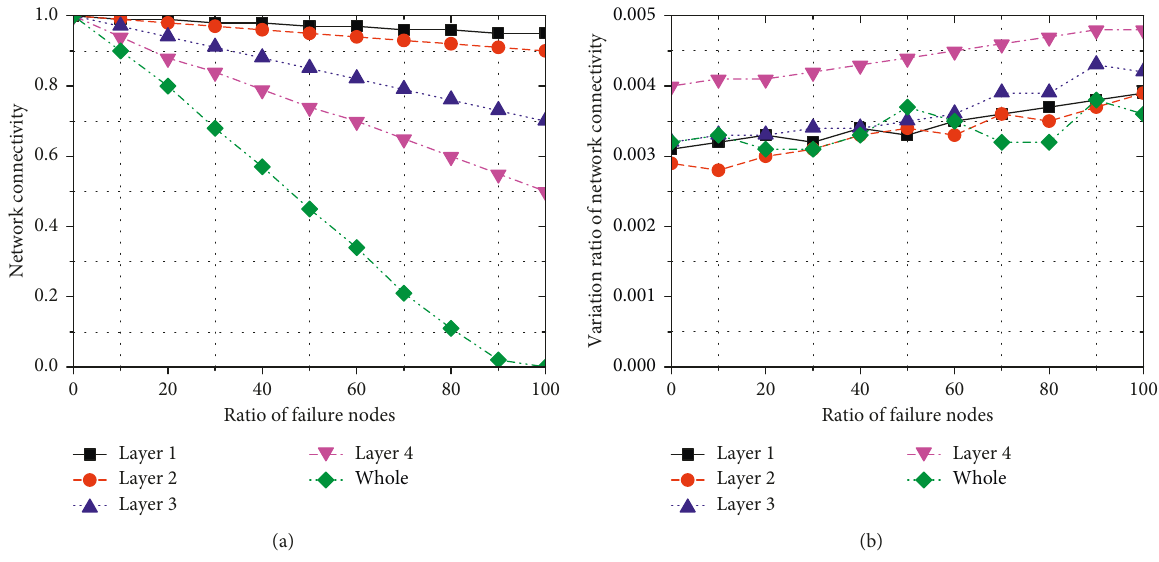
Figure 5: Network connectivity under targeted disruption. (a) Network connectivity. (b) Variation ratio of network